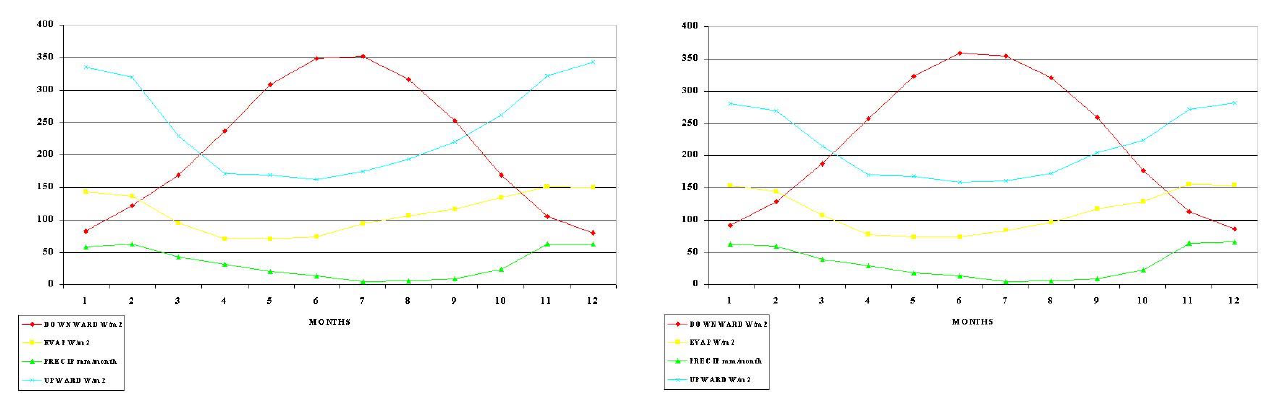
Fig. 5b. ECMWF surface forcing in the SW CYCOM model domain: annual cycle of downward and upward heat fluxes, precipitation and